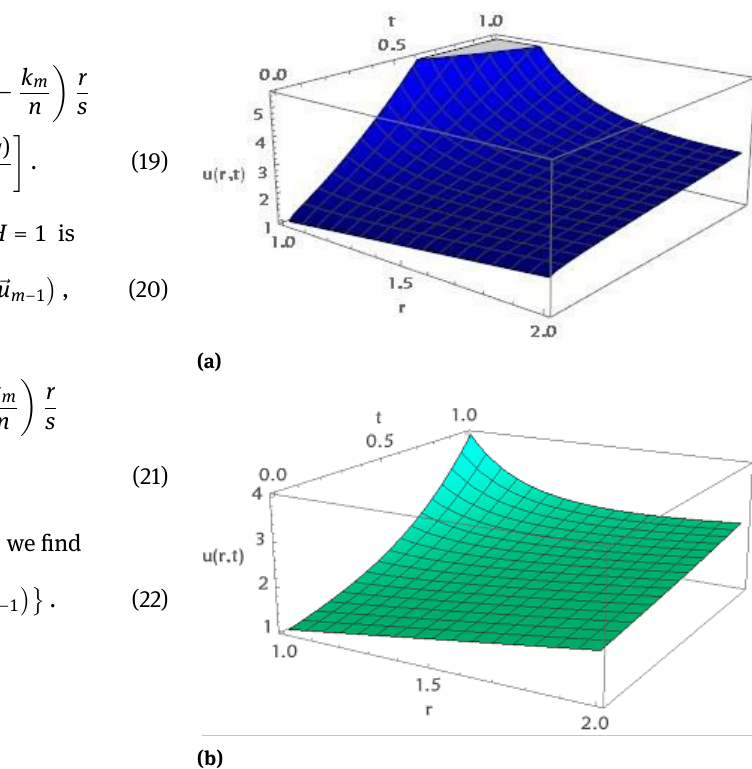
Fig. 1: Plots of q-HATM solution u ( r , t ) Vs. r , t when (cid:126) = −1, n = 1 , for (a) α = 0.5 (b) α = 1 , for Ex.